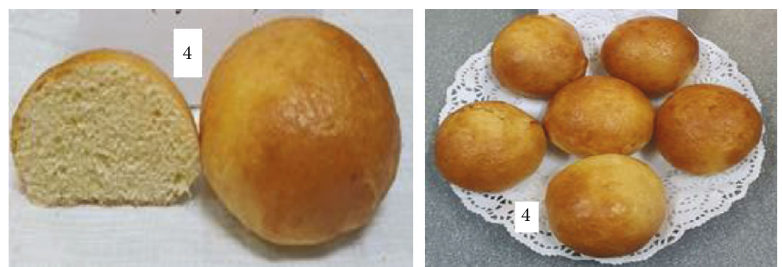
Figure 5: Sample no. 4 made from 15% chickpea fl our with